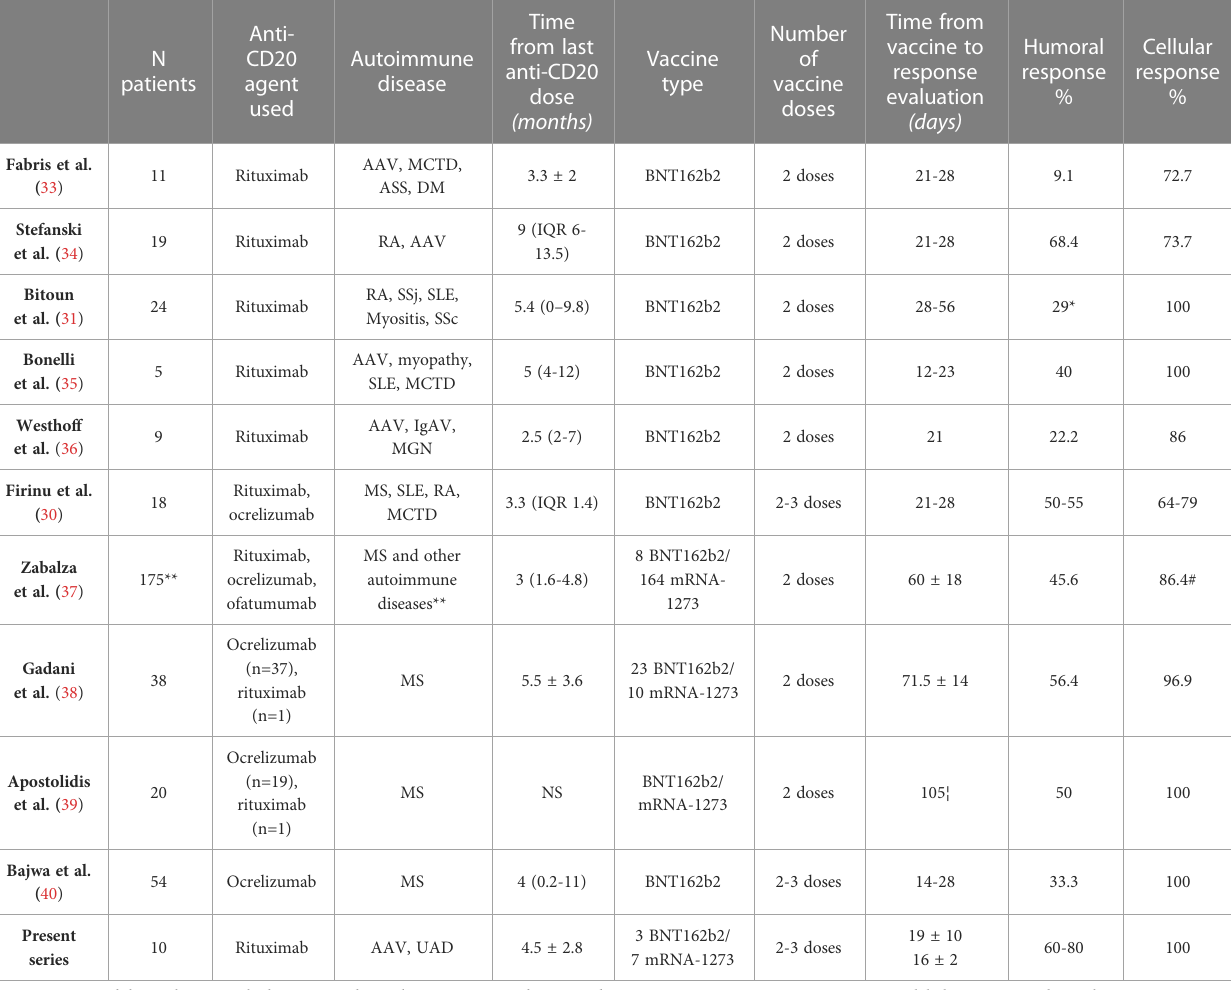
TABLE 2 Studies analyzing humoral and cellular responses to SARS-CoV-2 vaccines in patients with autoimmune diseases treated with anti-CD20